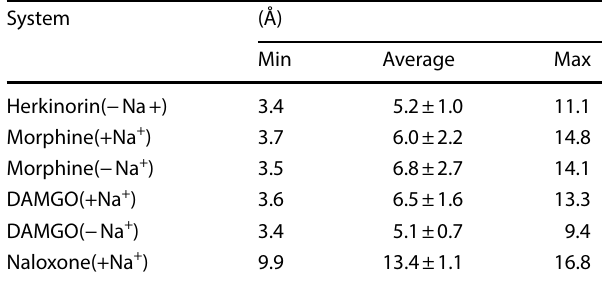
Table 1 Distance between atoms CE1 of Y336 7.53 and CZ of R165 3.50 in active μ-OR systems